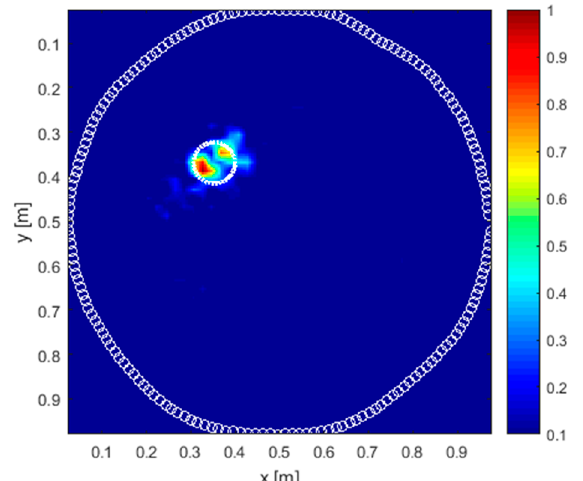
Figure 7. Tomographic reconstruction of the softwood scenario with time-gating up to 2 ns. The dashed white circle indicates the actual position of the anomaly. The circles in white solid line along the trunk perimeter represent the positions of the measurement points.